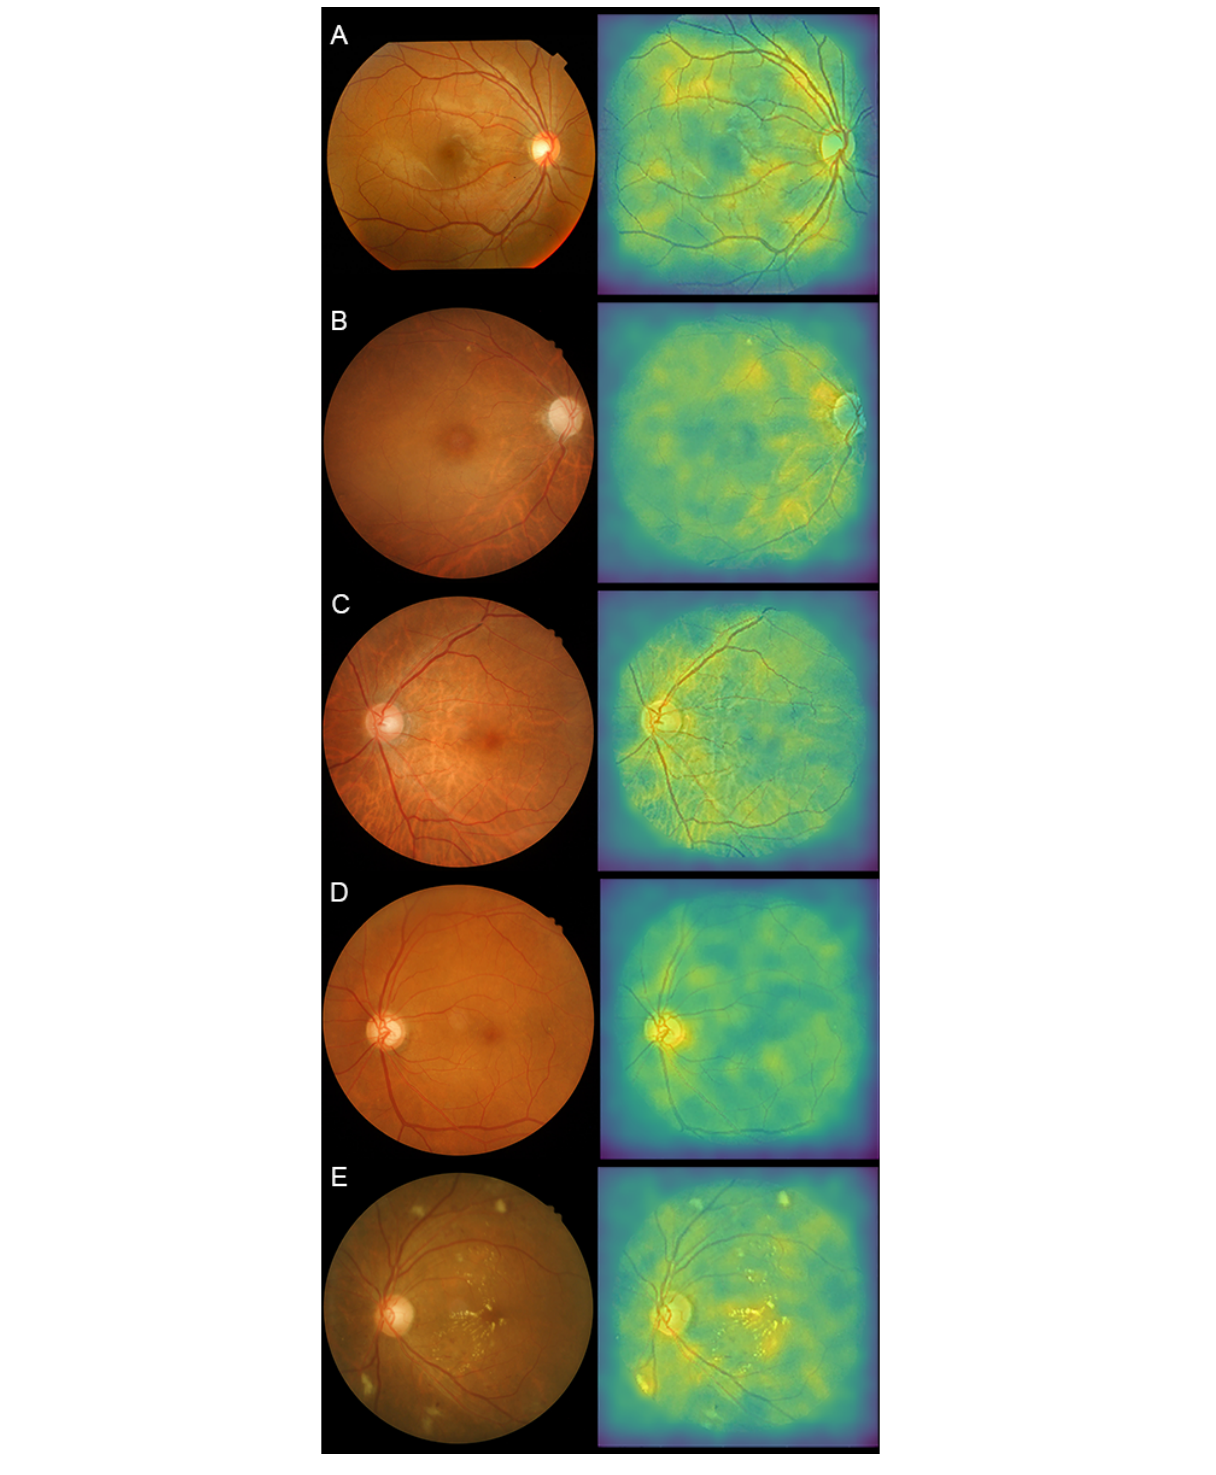
Figure 3. Selected retinal fundus images and their corresponding saliency maps in true-negative and true-positive cases. (A) No renal function impairment detected. Patient’s eGFR = 102.6 mL/min/1.73 m 2 and HbA 1c = 13.4%. (B) Renal function impairment detected. Patient’s eGFR = 40.0 mL/min/1.73 m 2 and HbA 1c = 5.1%. (C) Renal function impairment detected. Patient’s eGFR = 50 mL/min/1.73 m 2 and HbA 1c = 6.5%. (D) Renal function impairment detected. Patient’s eGFR = 80.5 mL/min/1.73 m 2 and HbA 1c = 7.3%. (E) Renal function impairment detected. Patient’s eGFR = 67.7 ml/min/1.73 m 2 and HbA 1c = 8.9%. eGFR: estimated glomerular filtration rate; HbA 1c : hemoglobin A 1c